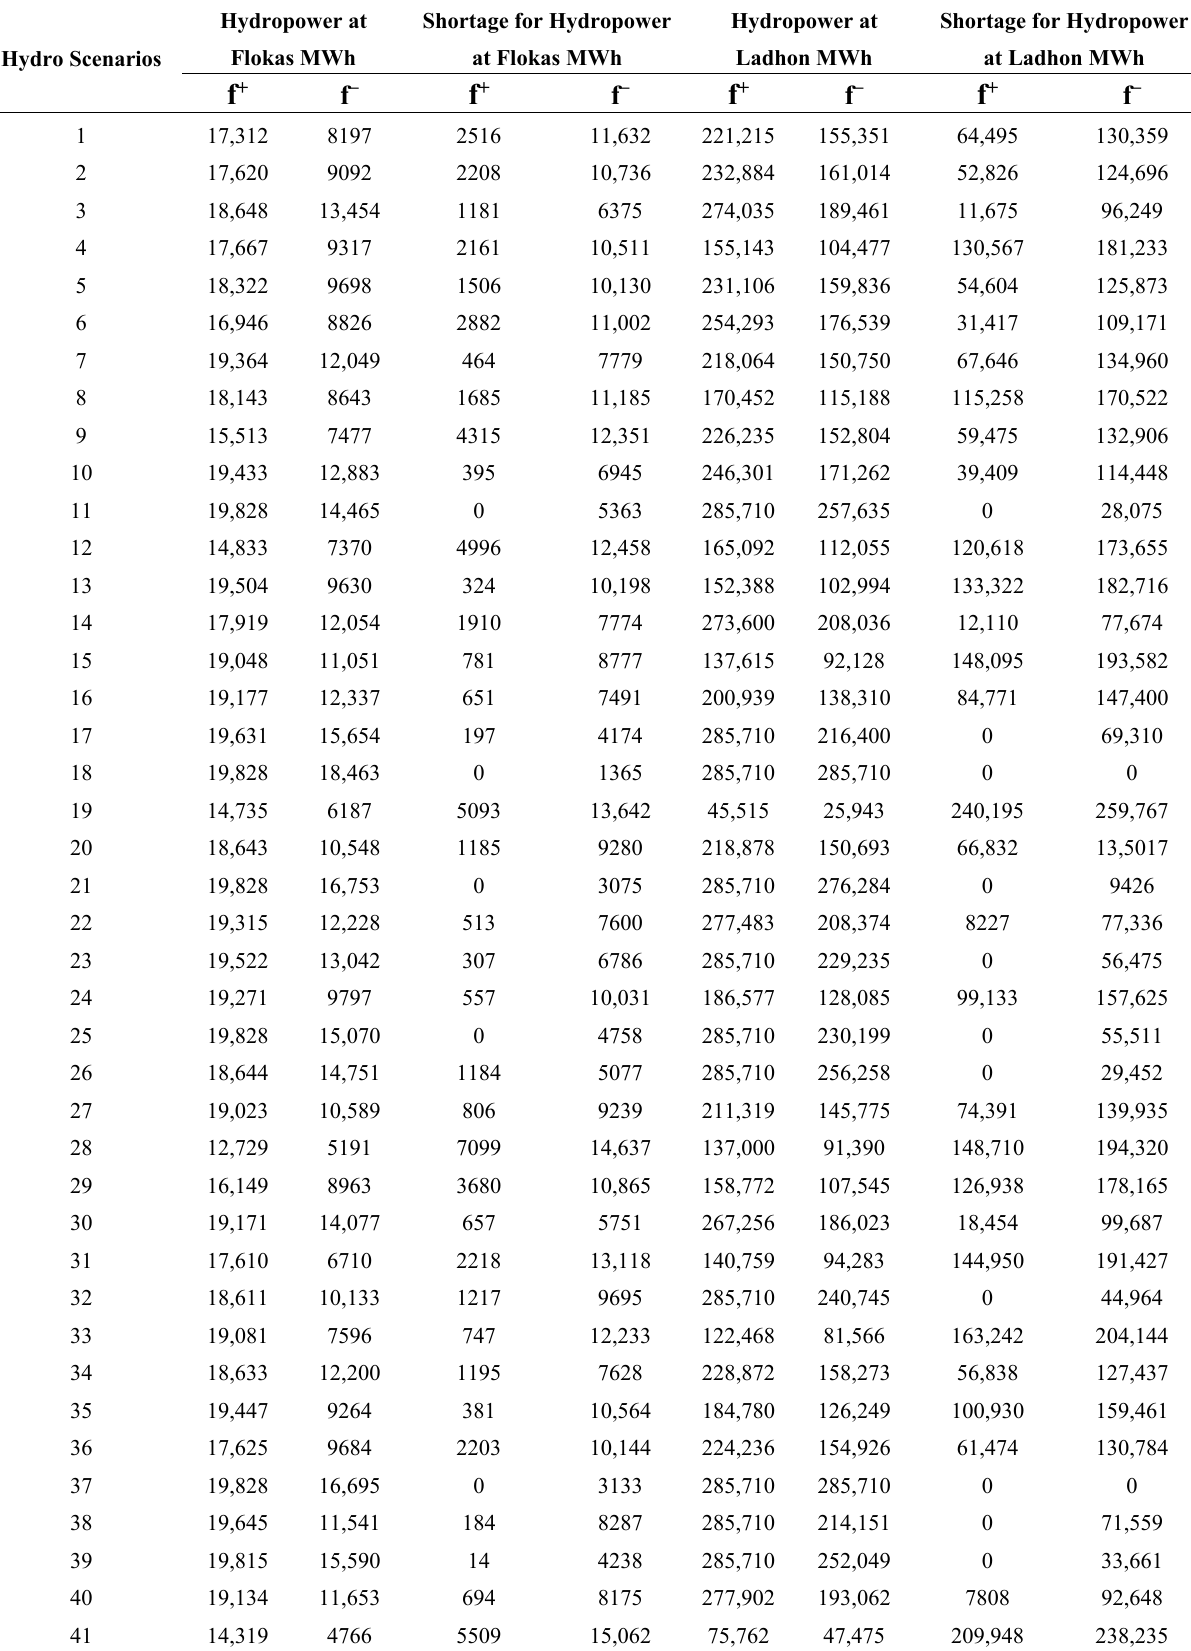
Table 18. Annual hydropower production and shortage at the HPS at Ladhon and at Flokas (MWh). Hydro